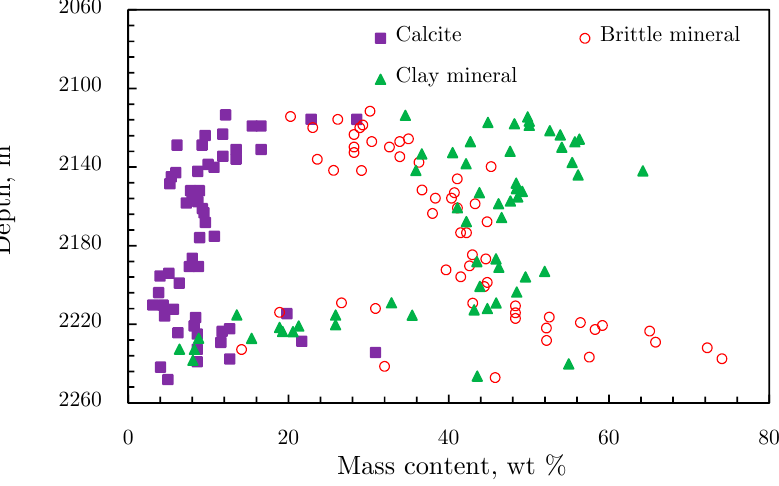
Figure 5. The relationship between mineral mass content and depth.